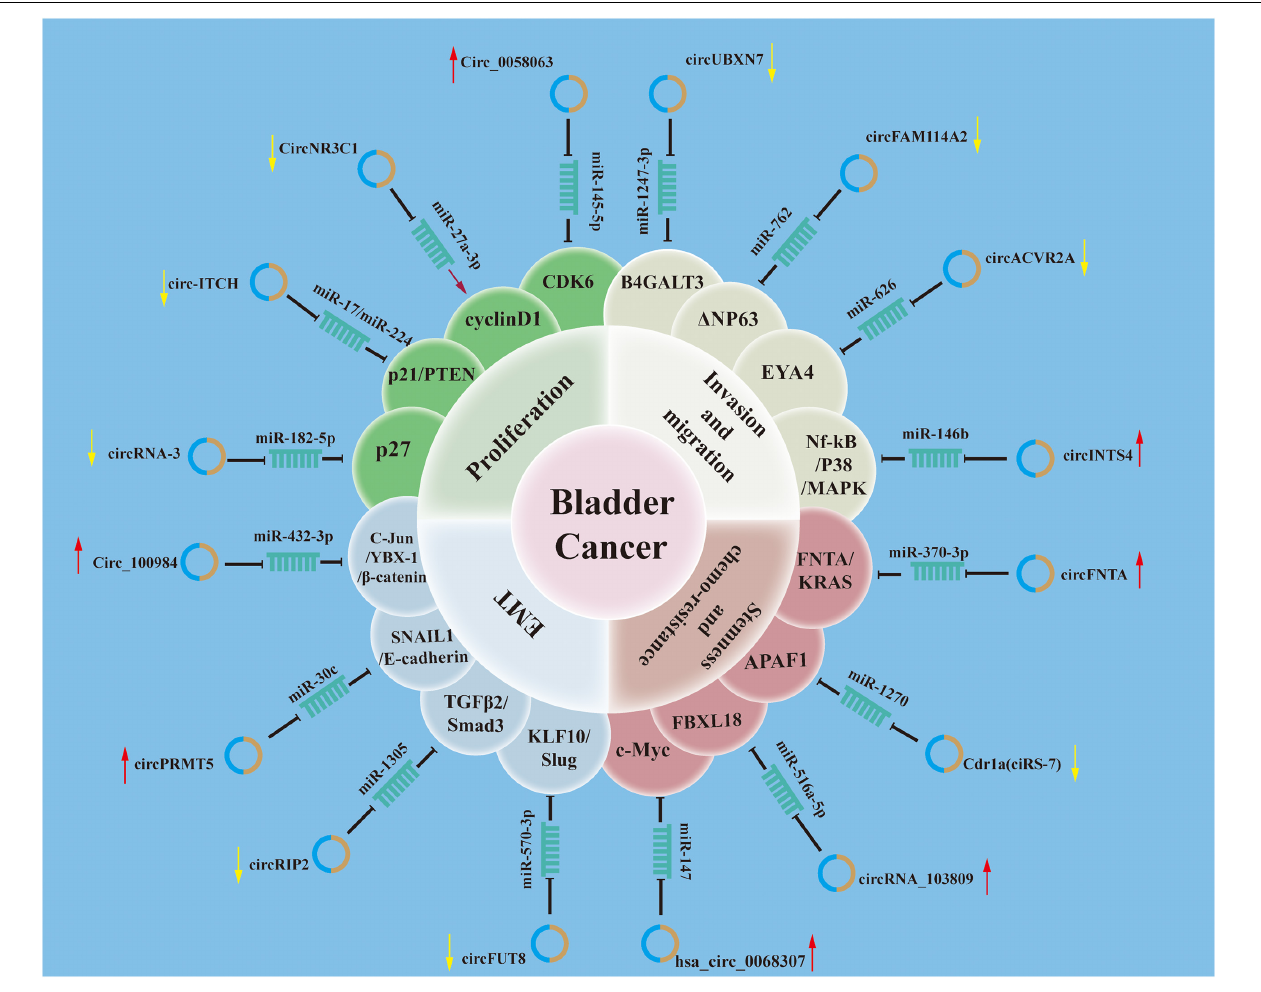
FIGURE 2 | Roles of circular RNAs (circRNAs) in mechanisms mediating tumorigenesis and progression of bladder cancer. The schematic diagram summarizes the roles of circRNAs in the progression and involvement of circRNAs–microRNA (miRNA)–targets axis of bladder